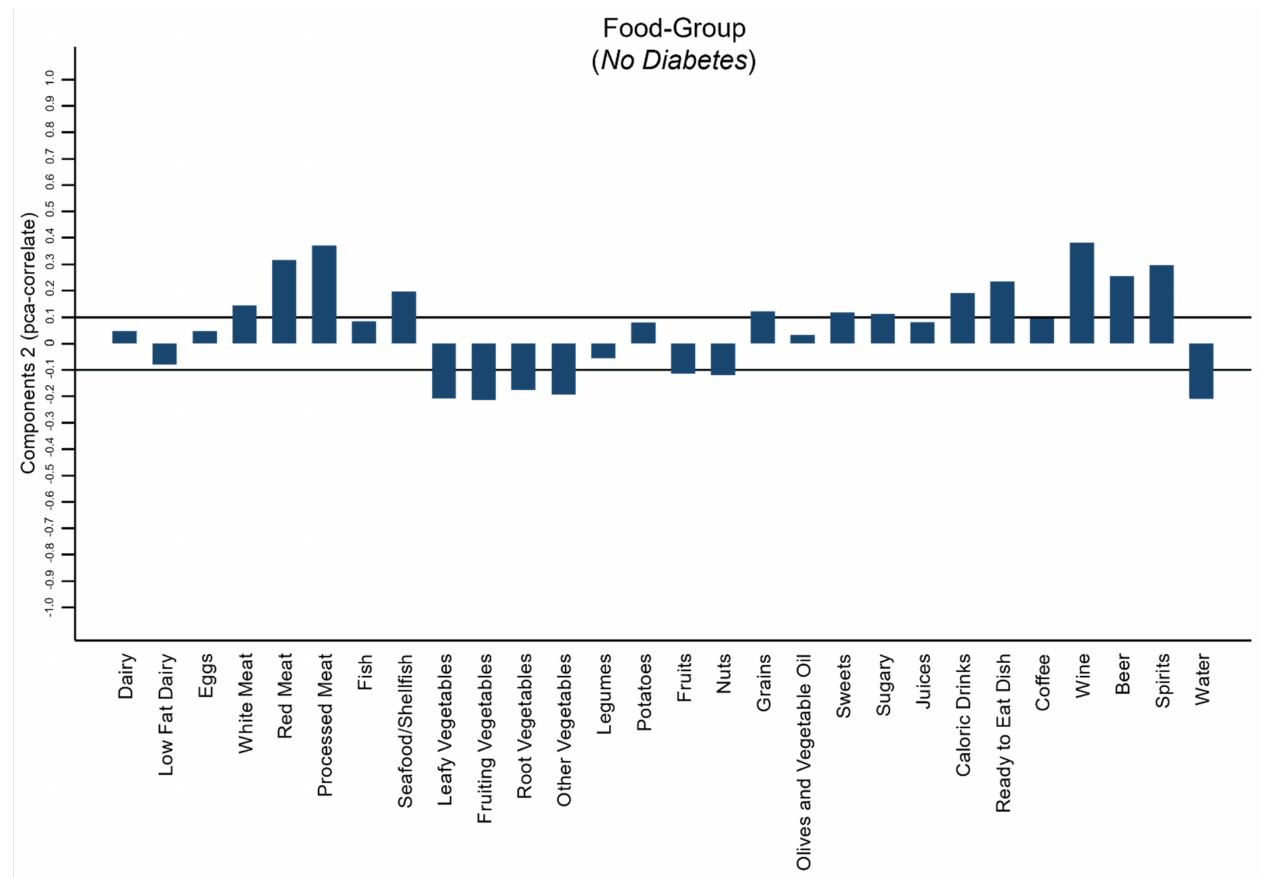
Figure 2. Principal component analysis (PCA) used to identify a dietary pattern of “Not Diabetic”